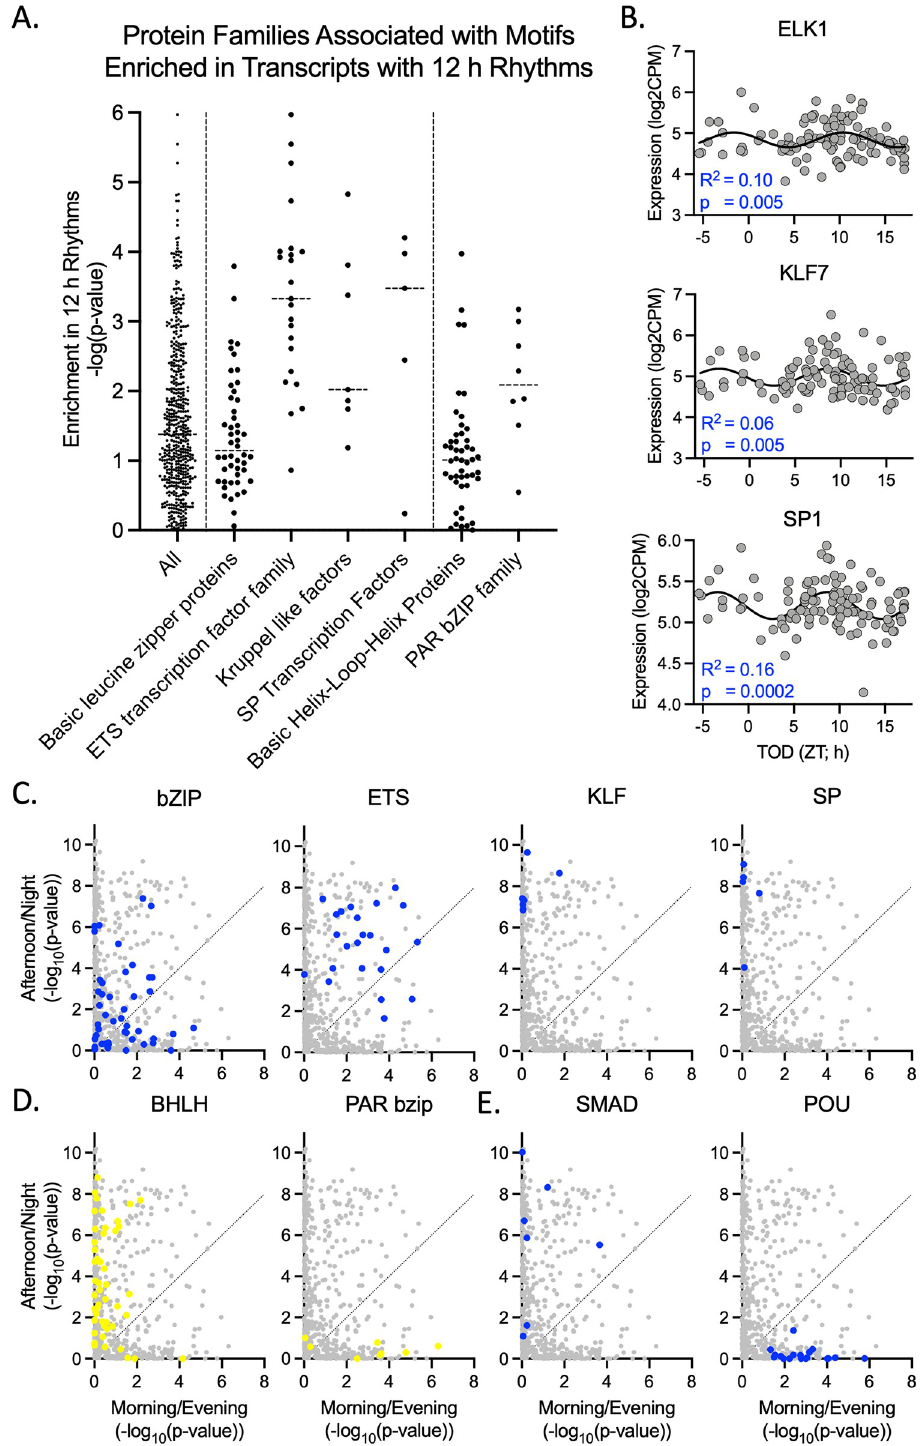
Fig 2. Protein families associated with motifs enriched in transcripts with 12 h rhythms. ( A ) Motif enrichment analysis of transcripts with 12 h rhythms in the human DLPFC. Dashed lines separate three groups: (1) All motifs tested; (2) Protein families previously implicated in regulating 12 h rhythms; (3) Protein families previously implicated in regulating 24 h rhythms. ( B ) Examples of transcription factors from ETS domain (Elk1), Kruppel-like factor (KLF7), and SP transcription factor (SP1) families that have 12 h rhythms in human DLPFC. Expression values for these graphs